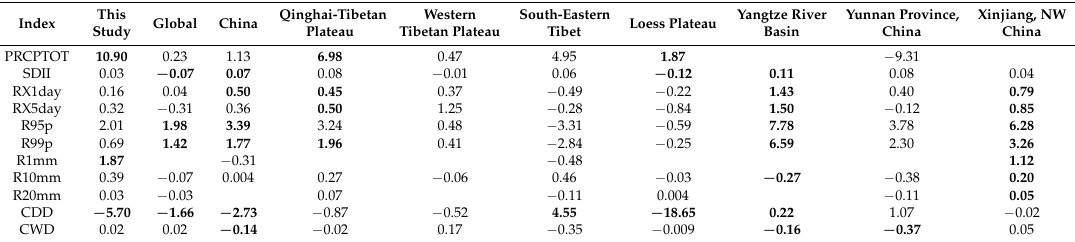
Table 8. Extreme precipitation indices from this study and other works around the